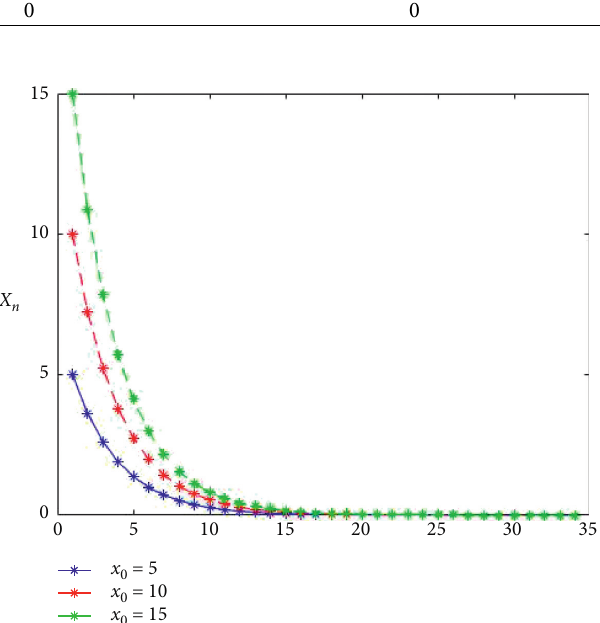
Figure 1: The convergence graph of the sequence x